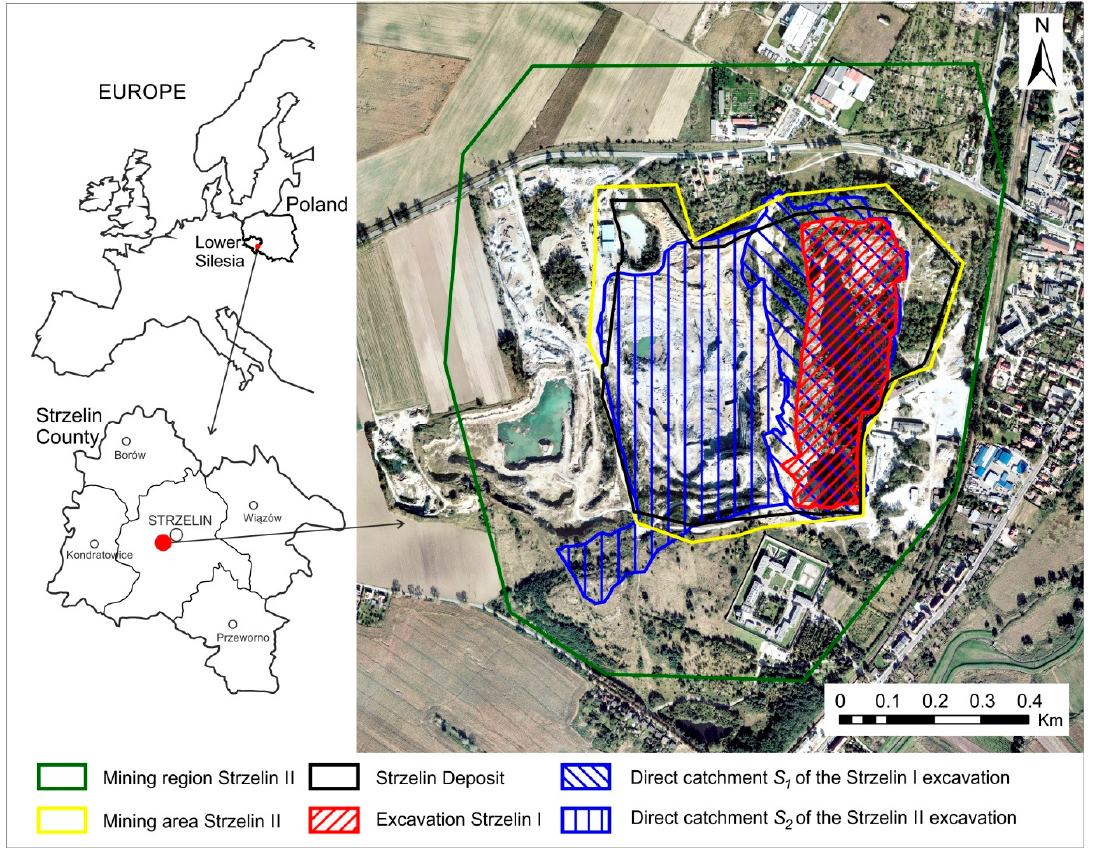
Figure 1. Location of the Strzelin granite quarry a scheme map of Europe, Poland, and the Strzelin County, as well as the reach of the Strzelin I pit and the direct catchments S 1 and S 2 (orthophotomap from 3 October 2013 (licence no. DIO.7211.195.2017_PL_N for Institute of Landscape Architecture, Wroclaw University of Environmental and Life Sciences)).